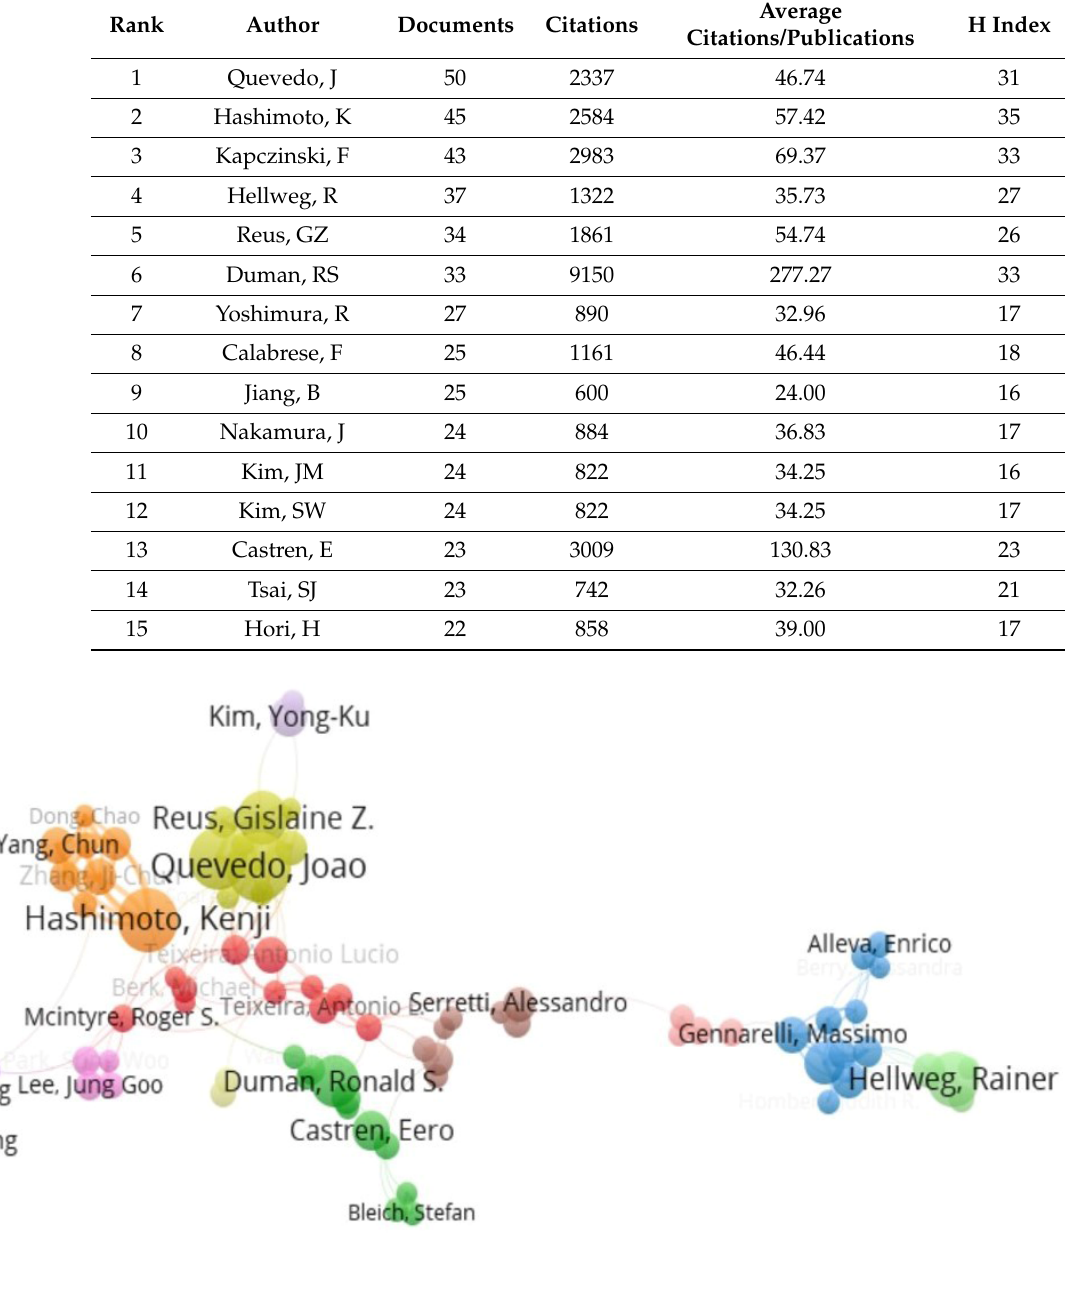
Table 1. Contributions of authors. The top 15 authors for the association between depression and BDNF research.